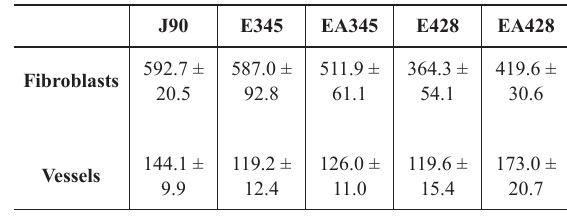
P > 0.05 when all the groups were